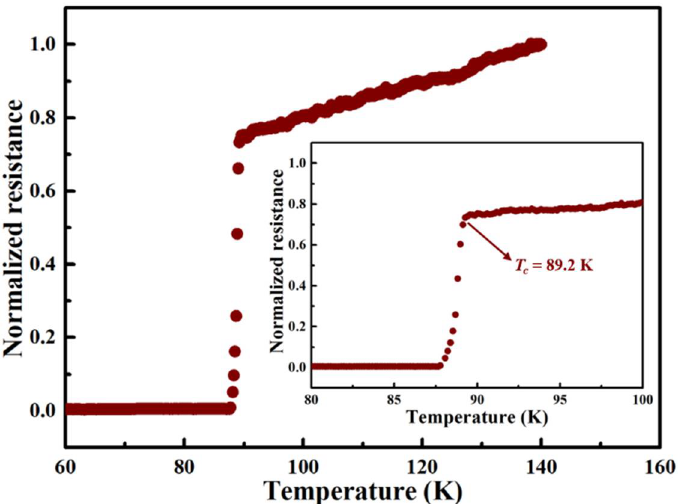
Figure 10. Superconducting transition characteristics ( T-R curve) of low-vacuum pyrolysis film after 815 °C treatment. The inset is a partial enlargement of the T-R curve.